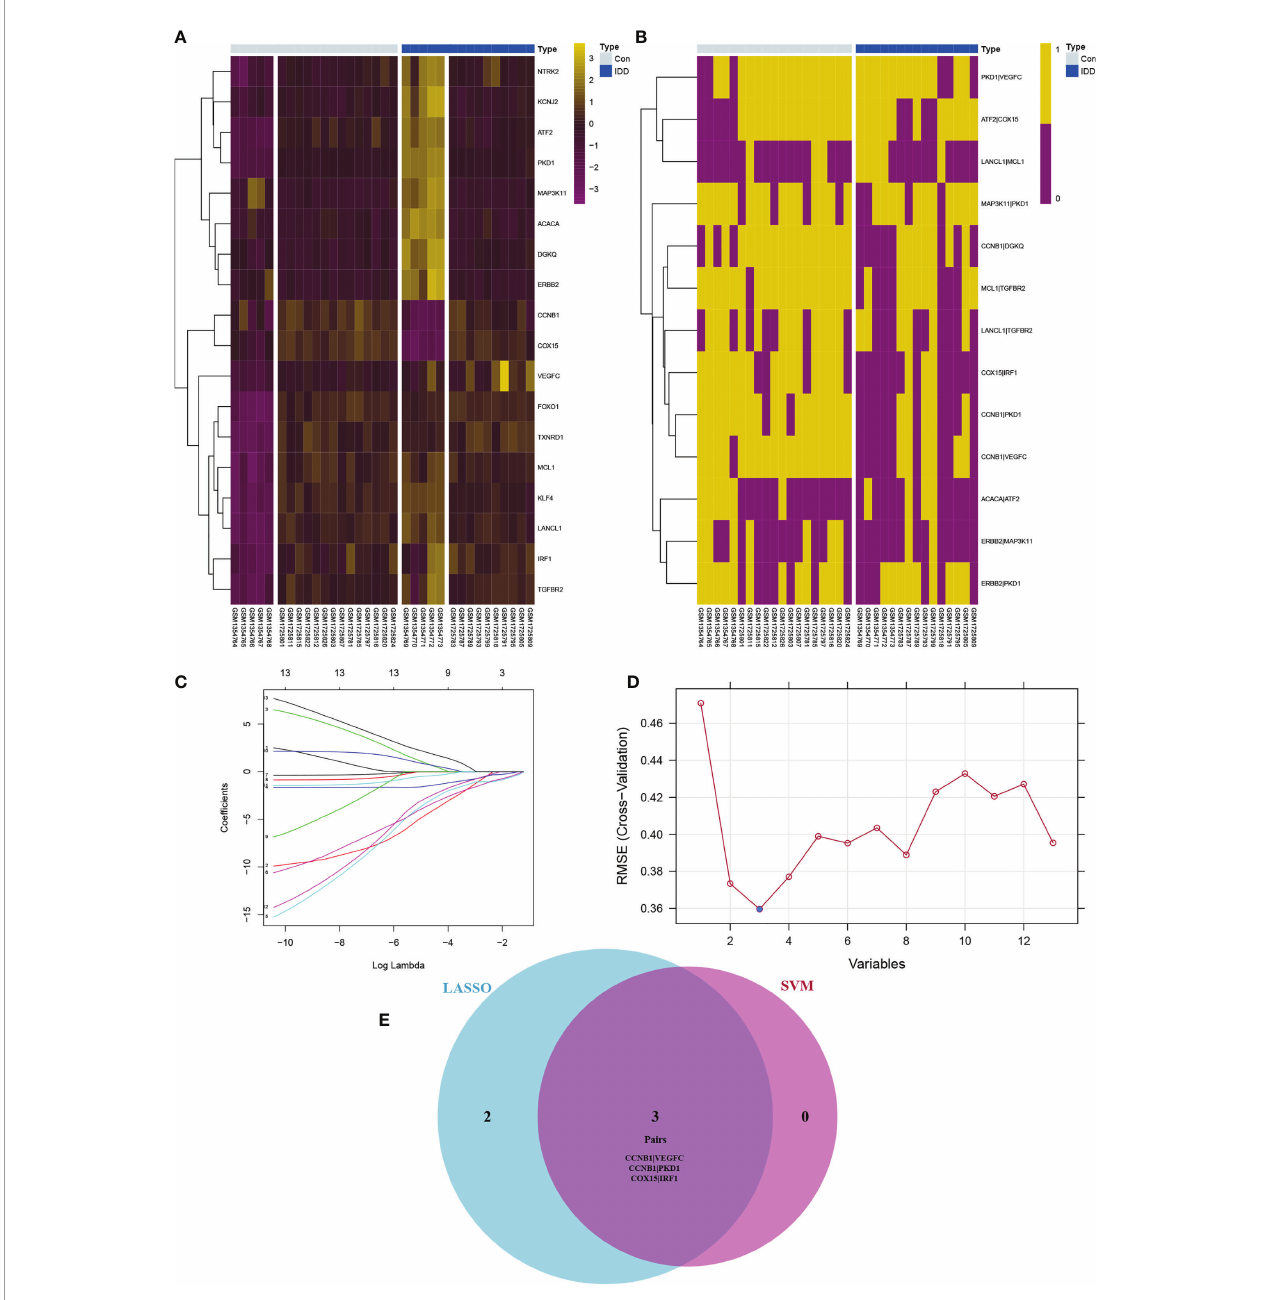
FIGURE 3 | The expression pro fi le for De-OSRGs (A) and De-OSRGPs (B) . The difference between OSRGs heat map and OSRGPs heat map (A, B) : although the batch correction is used, the gap between different datasets can be clearly shown in panel (A) The screening process of key OSRGPs for IDD. (C) LASSO regression to screen for candidate signatures. (D) SVM to screen for candidate signatures. (E) Venn diagram demonstrating the intersection of candidate signatures screened by LASSO regression and SVM. OSRGs, oxidative stress-related genes; OSRGPs, oxidative stress-related gene pairs; IDD, intervertebral disc degeneration; LASSO, least absolute shrinkage and selection operator; SVM, support vector